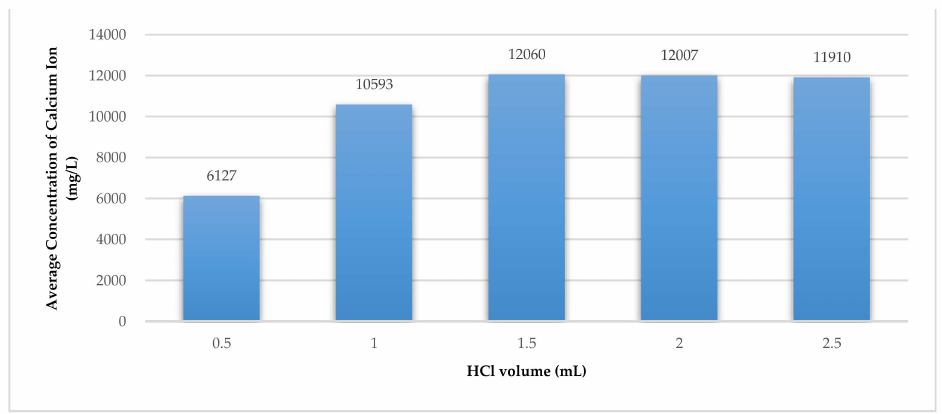
Figure 5. Calcium ions extracted from